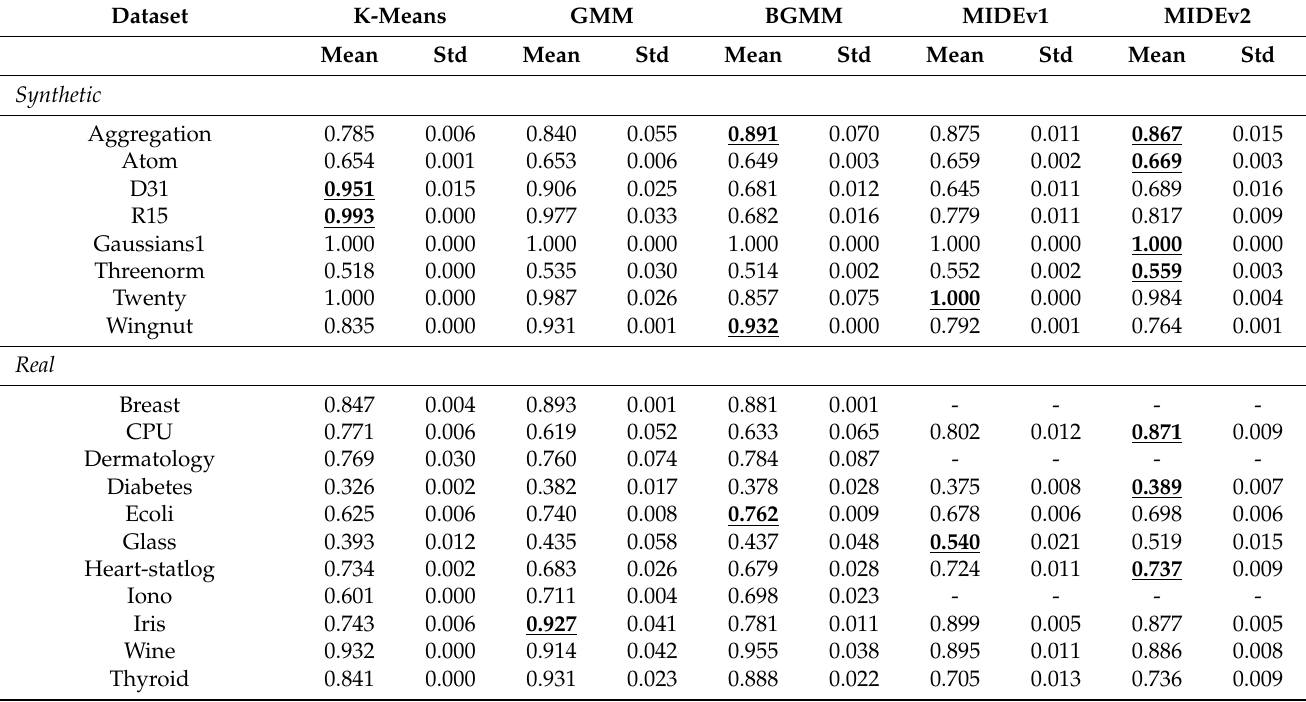
Table A4. Different models were compared (means and standard deviation) based on the Fowlkes– Mallows index (FMI) for 10,000